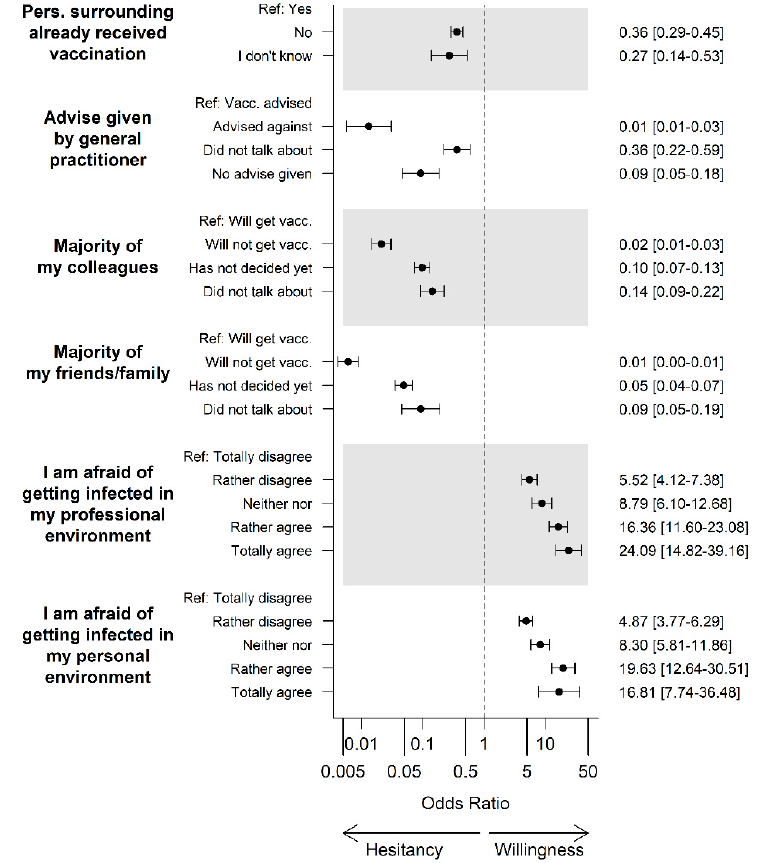
Figure 6. Personal environment and attitude towards COVID-19 vaccination. Abbreviations: Vacc., vaccination; GP, general practitioner; Pers., persons; Ref, reference.